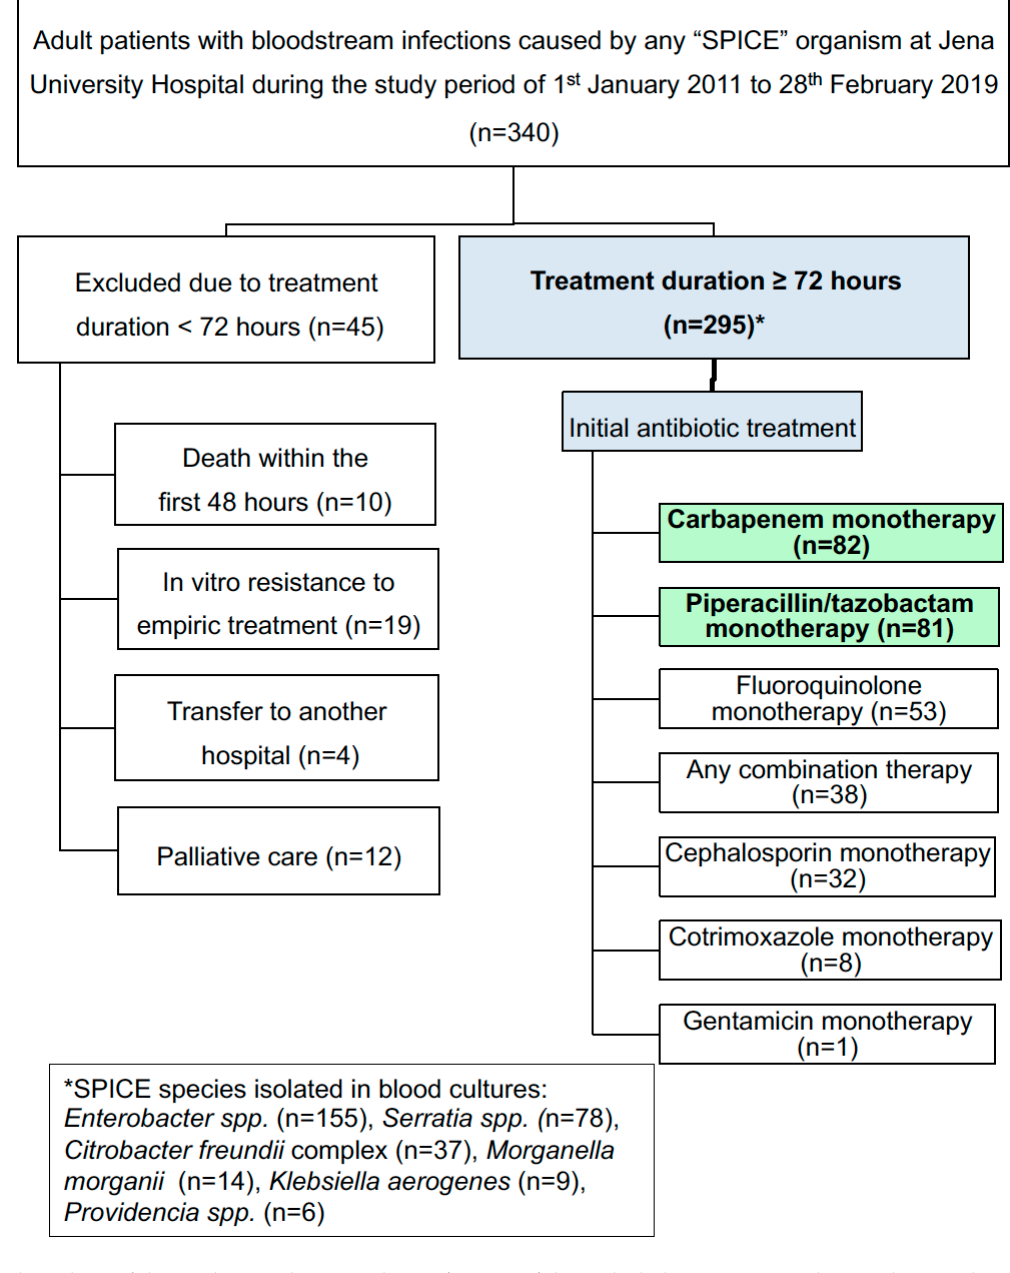
Figure 1. Flow chart of the study population and stratification of the included patients according to the initial antimicrobial treatment. Only patients with antimicrobial treatment for at least 3 days were considered for the study. Carbapenem monotherapy involved imipenem/cilastatin ( n = 2) or meropenem ( n = 80). Cephalosporin monotherapy involved cefuroxime ( n = 2), ceftriaxone ( n = 19), cefotaxime ( n = 1) or ceftazidime ( n = 10). Fluoroquinolone monotherapy involved ciprofloxacin ( n = 45) or moxifloxacin ( n = 8). Combination therapy involved piperacillin/tazobactam plus ciprofloxacin ( n = 31), piperacillin/tazobactam plus ceftriaxone ( n = 1), piperacillin/tazobactam plus gentamicin ( n = 1), ceftazidime plus gentamicin ( n = 1), gentamicin plus ciprofloxacin ( n = 1), meropenem plus gentamicin ( n = 1), meropenem plus fosfomycin ( n = 1) or meropenem plus moxifloxacin ( n = 1).